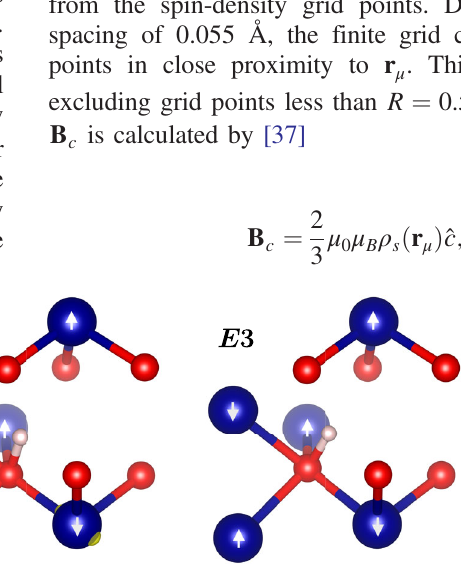
) for the charge-neutral E 1 and E 2 sites. z 2